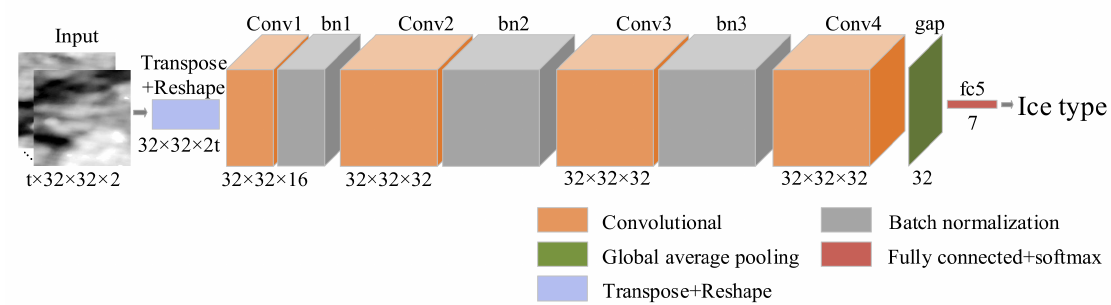
Figure 8. Sea ice classification network architecture based on